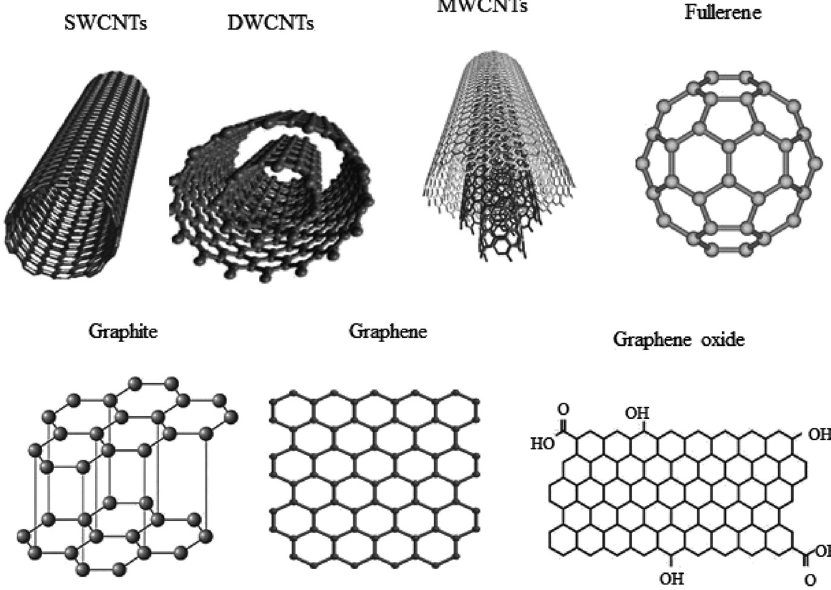
Figure 1: Di ff erent structures of carbon nanomaterials ( CNMs ) [ 27 ]